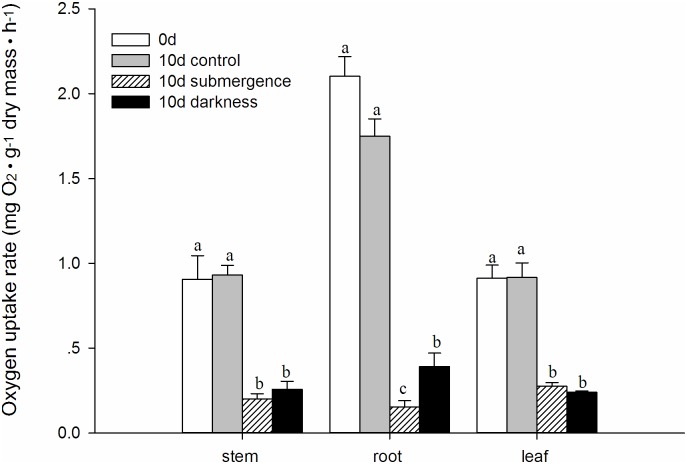
Respiration rate (mg O2 · g-1 dry mass · h-1) in different tissues (stem, root and leaf) of A. philoxeroides plants subjected to various treatments.The respiration rates were measured on day 0 prior to the initiation of the treatments (white and open columns) and on day 10. Three treatments were performed in this study: (1) well drained and illuminated (gray and closed columns), (2) submergence in darkness (gray and crossed columns) and (c) non-submergence in darkness (black and closed columns). The total amount of oxygen uptake was recorded and calculated on a dry mass basis in each tissue. The data are presented as the means ± SE, n = 5. Different letters indicate significant differences within each tissue (P < 0.05), and the same letters indicate no differences within each tissue (P > 0.05).